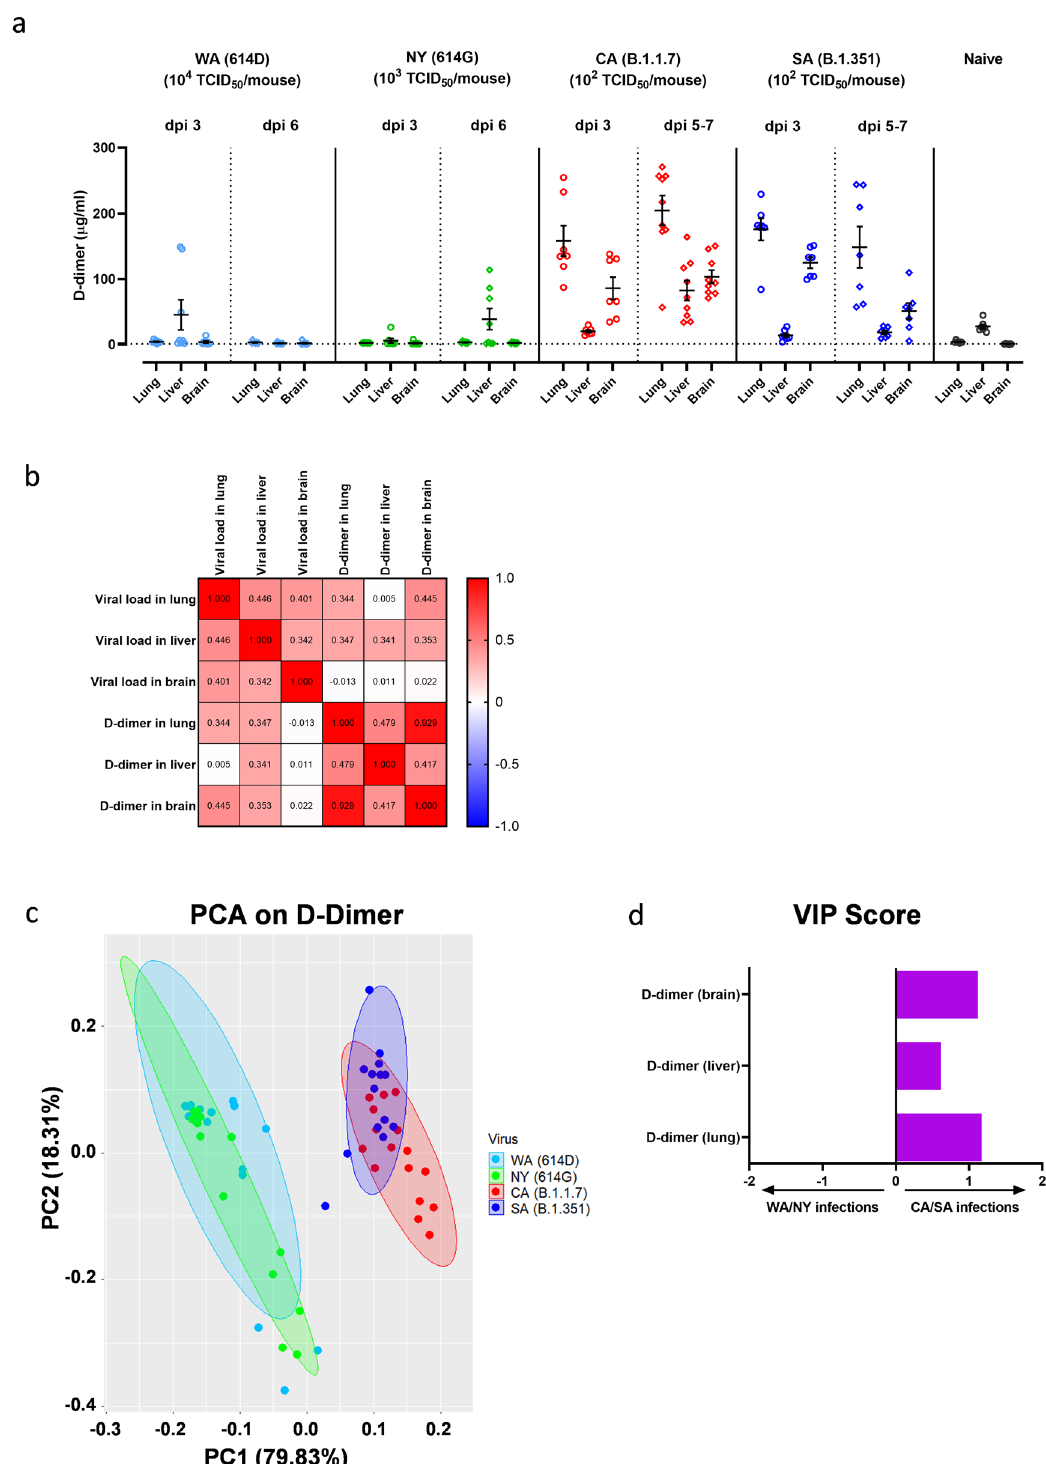
protocol used for titrating in fl uenza virus 58 . Brie fl y, virus was diluted in ½ log10 in minimum essential medium (MEM) supplemented with 2% aseptically fi